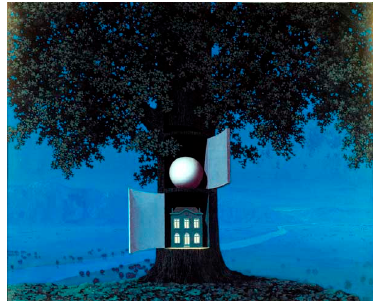
Figure 18. R. Magritte, Voix du sang , 1961.